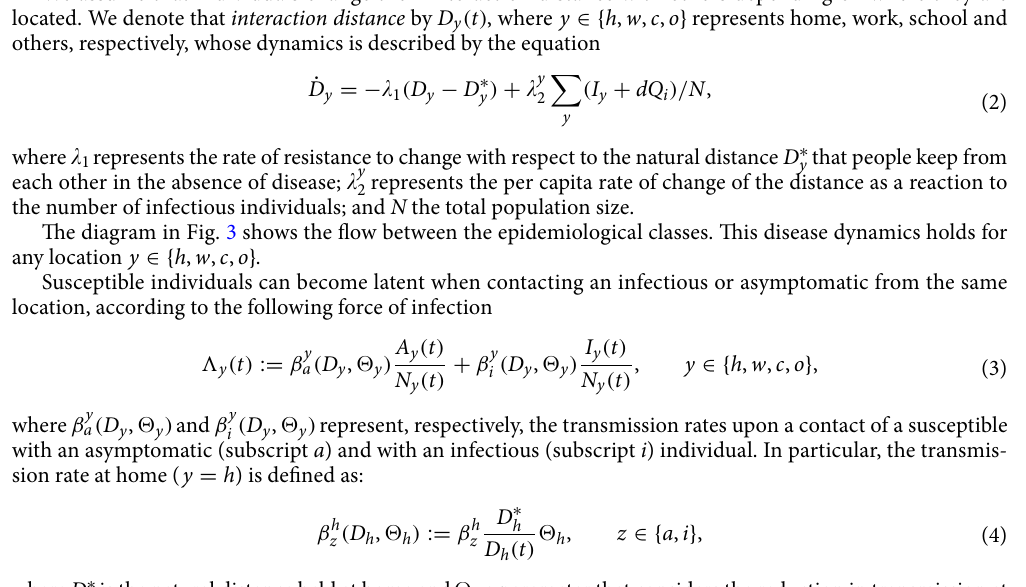
home due to home-exit restrictions. More specifically, observe that the transmission rate decreases when D h ( t ) increases from the natural distance D ∗ h . When D h ( t ) is equal to D ∗ h , the disease gets transmitted at a base line transmission rate β h z , times the parameter (cid:31) h . The latter represents the reduction in the home-transmission rate when reducing by Red x the proportions α ∗ x , x ∈ { w , c , o } , which are the proportions by which people leave the home ( h ) location under normal conditions. This way, (cid:31) h is defined as